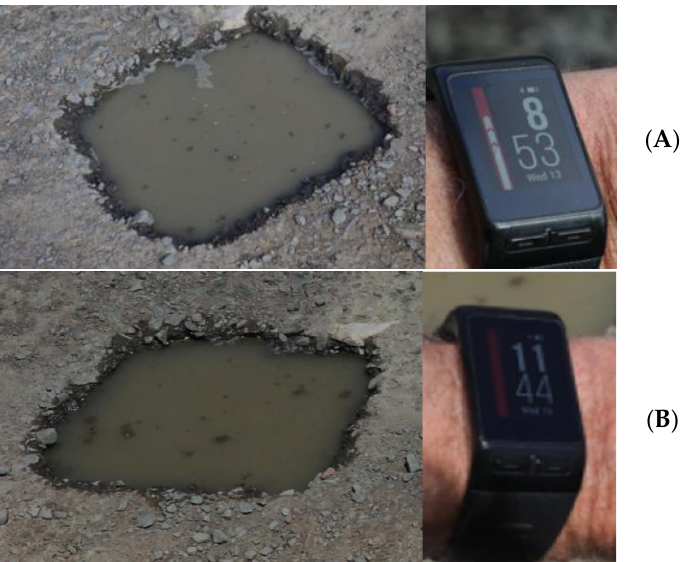
Figure 4. Low permeability demonstration of well compacted and slushed crushed stone base: ( A ) onset and ( B ) after a period. ( A ) Water level at start at 8:53. The sample hole was filled with water. Immediate seepage of moisture was visible at the surface (approximately 20–40 mm), but then becomes standing. ( B ) No significant reduction in the water level was visible over a period of three hours and was observed even over a period of 8 h.